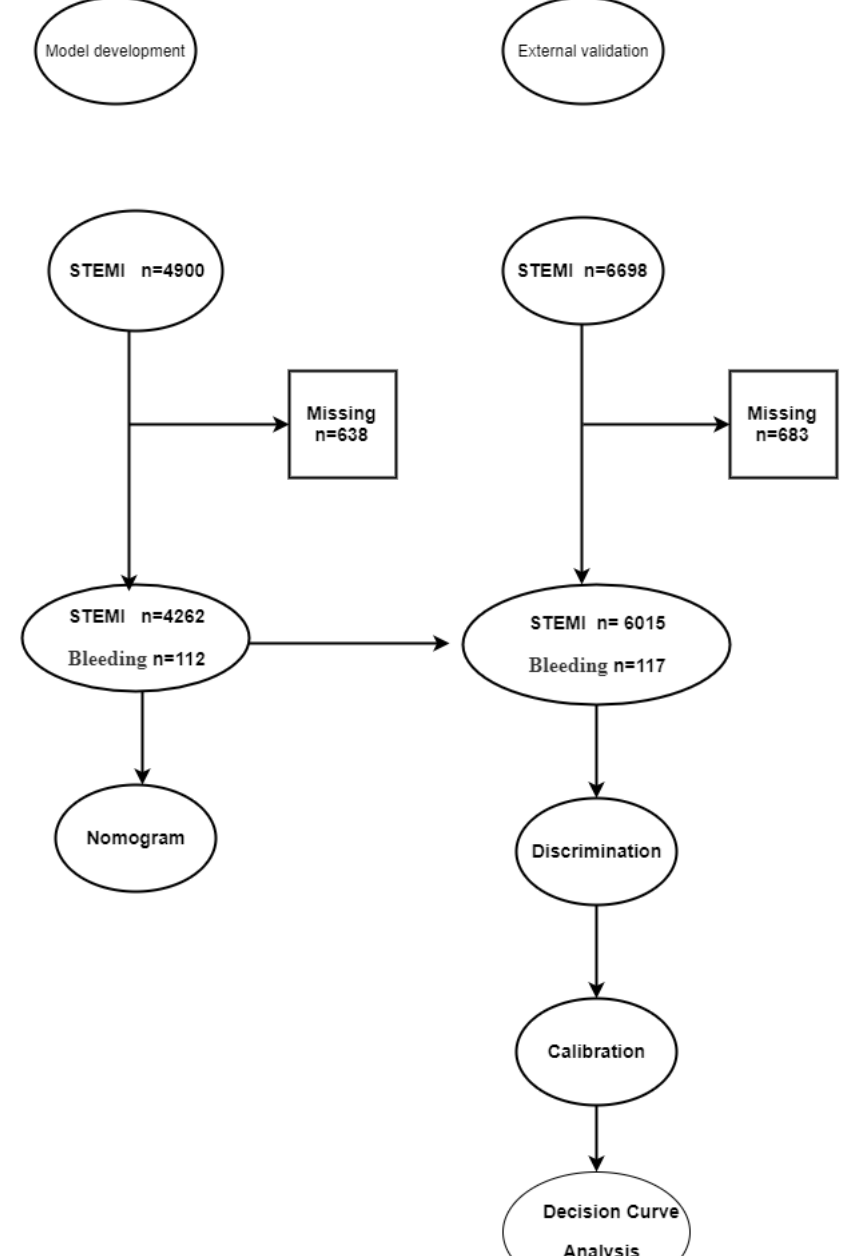
Figure 1. Flow diagram of the study. STEMI: ST-segment elevation myocardial